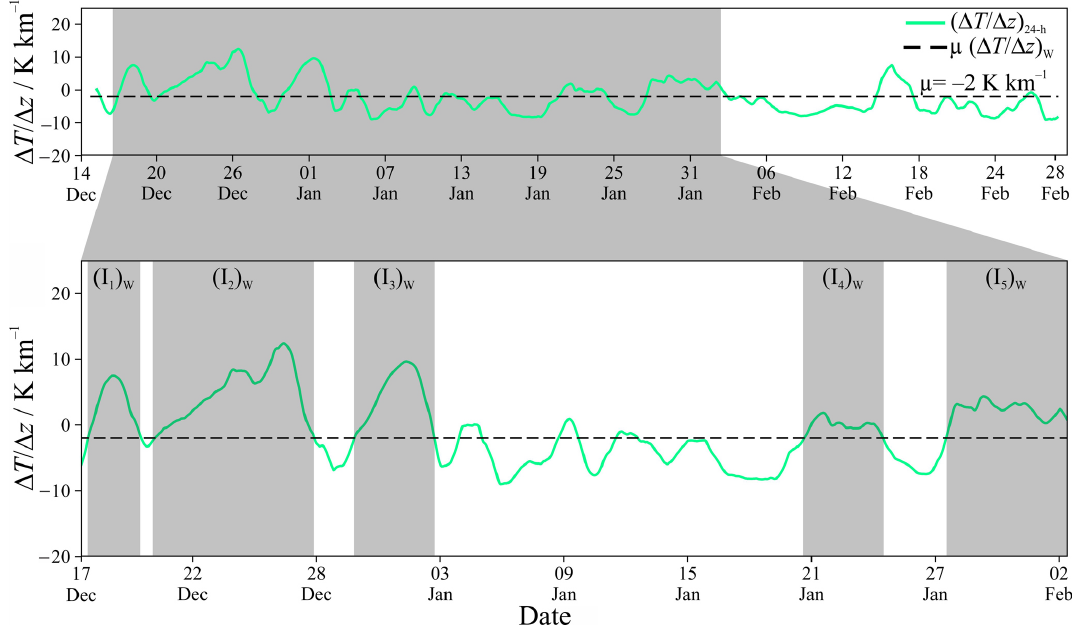
Figure 4. The 24h running mean pseudo-vertical temperature gradient in winter. Five persistent temperature inversion events ( I i ) W detected by the TGM are shown in the shaded area and enlarged in the breakout panel beneath; see text in Sect. 2.3.2 for